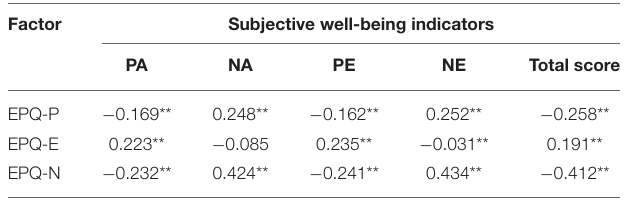
TABLE 6 | Comparison of multiple differences of subjective well-being total score and factor score in piano learning group. Total score PE NE